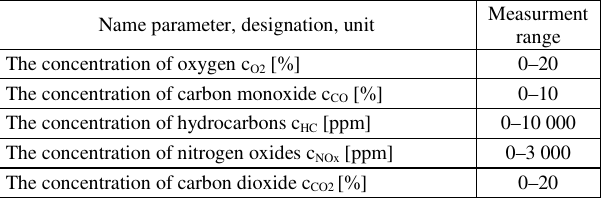
Table. 2. Characteristics of the Semtech-DS